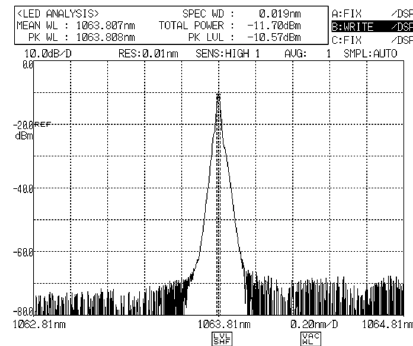
Figure 4. Power spectrum for the amplifier output power.